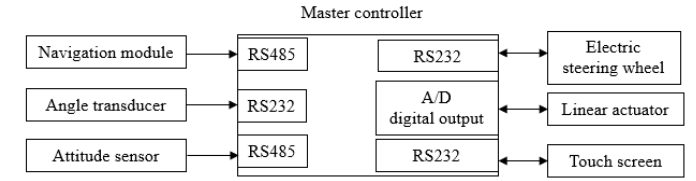
Figure 5. Construction diagram of the system.